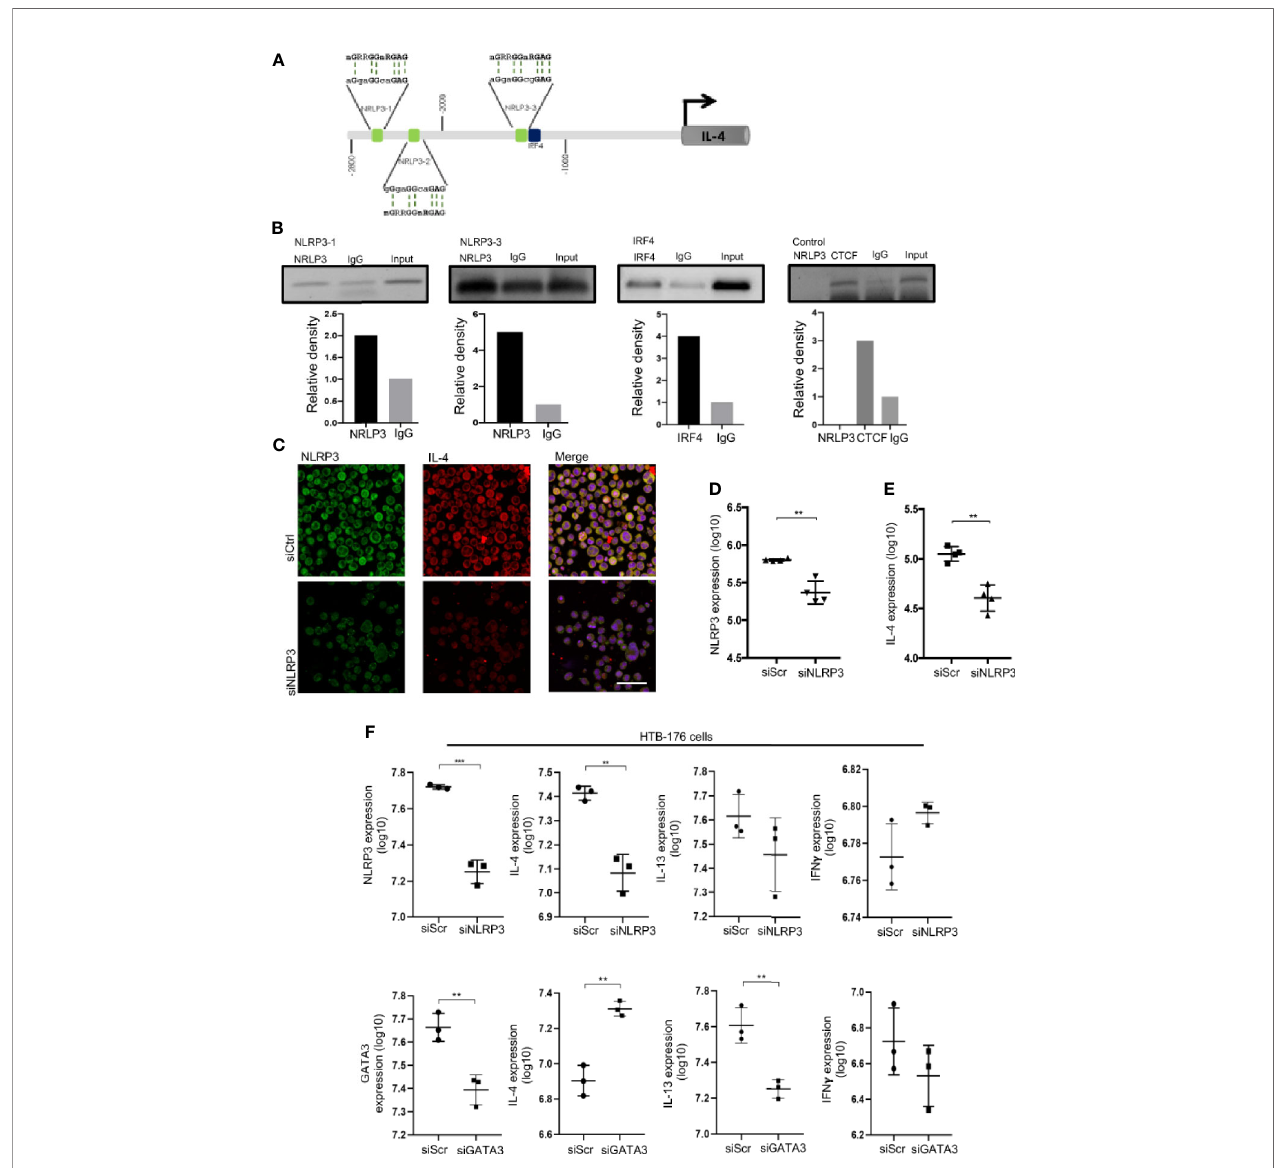
FIGURE 3 | NLRP3 binds to the il-4 promoter and regulates IL-4 expression in malignant CD4 + T cells from CTCL patients. (A) Schematic representation of the localization of three putative NRLP3 and one IRF4 binding site in the region from -2800 to -1000 bp relative to the transcription start site in the il-4 promoter. (B) ChIP of NLRP3 and IRF4 in HTB-176 cells, quanti fi cation of binding to NRLP3 site 1 (NLRP3-1) and site 3 (NLRP3-3), and binding to IRF4 (n = 2). (C) HTB-176 cell line was transfected with siNLRP3 and siScr using HiPerfect, and representative microphotographs depicting NLRP3 (AF-488) and IL-4 (AF-594) expression in transfected cells. Quanti fi cation of total expression of (D) NLRP3 and (E) IL-4 in the microphotographs after transfection (n = 4). (F) HTB-176 cell line was transfected with siNLRP3, siGATA3 and siScr using Lipofectamine. Quanti fi cation of the total expression of NLRP3, GATA3, IL-4, IL-13 and IFN g in microphotographs after transfection (n = 3). Error bars = SEM; **P < 0.01; ***P < 0.001. Scale bars= 20